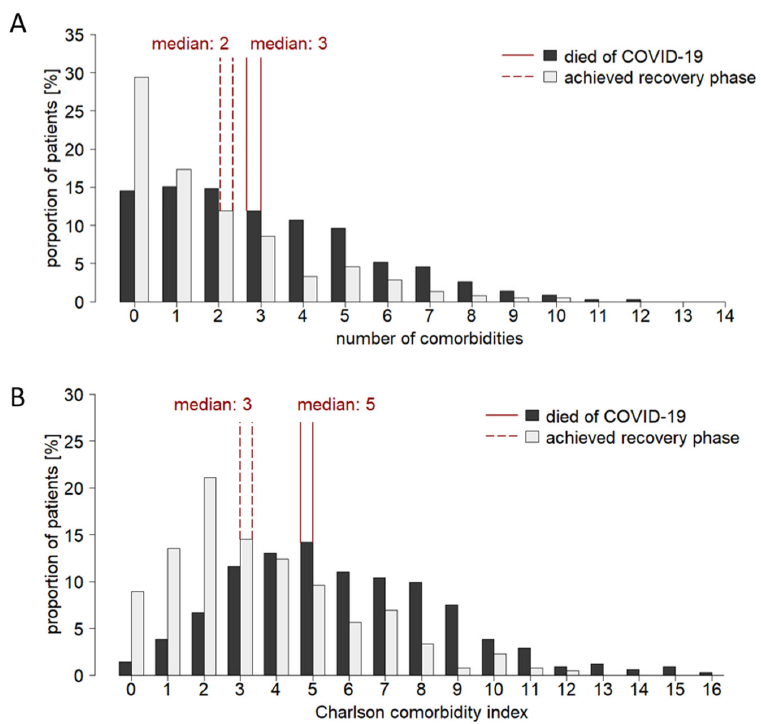
Figure A2. Distribution of ( A ) the number of comorbidities and ( B ) the Charlson comorbidity index in recovered and deceased COVID-19 patients receiving intensive care (total cohort, n = 840).